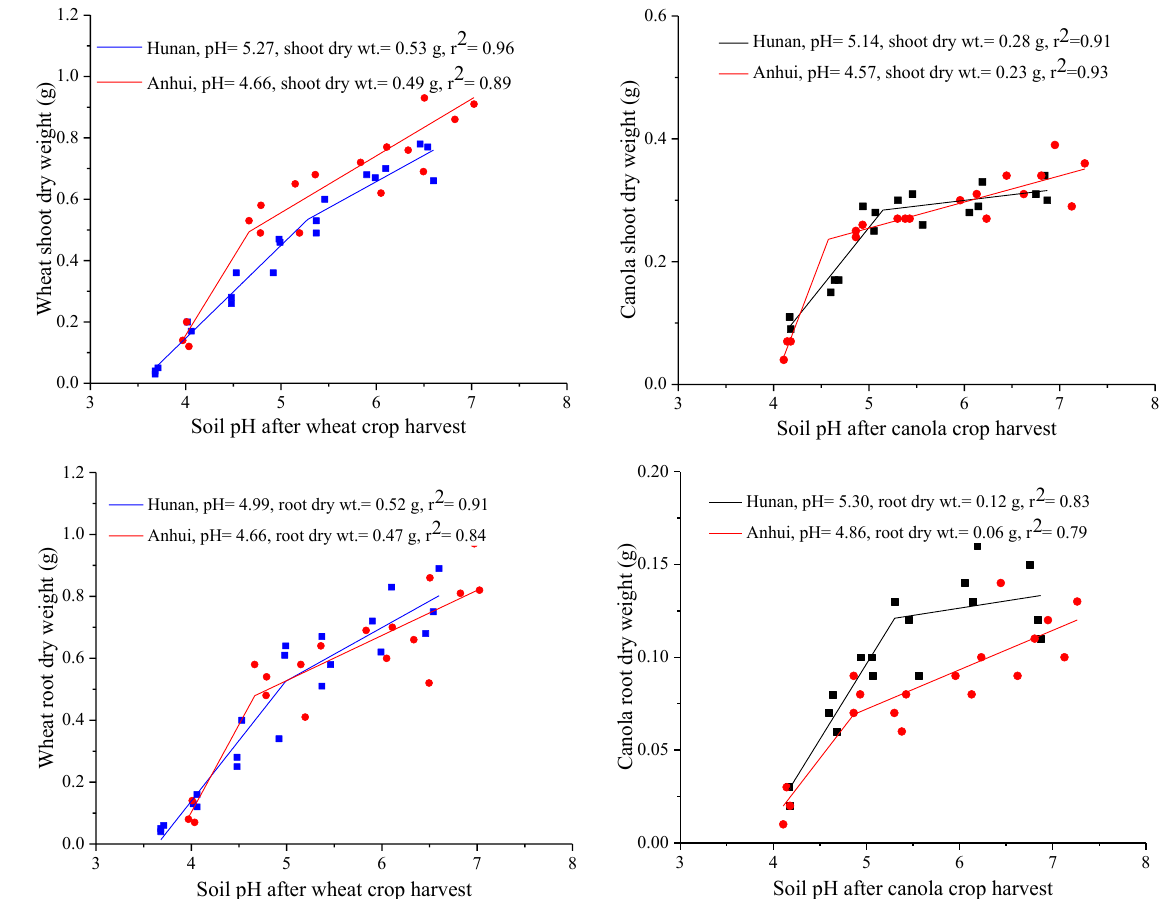
Figure 4. Dry weights of plant shoots and roots of wheat and canola as a function of soil pH of the Ultisols from Hunan and Anhui. The fitted equations were significant at P